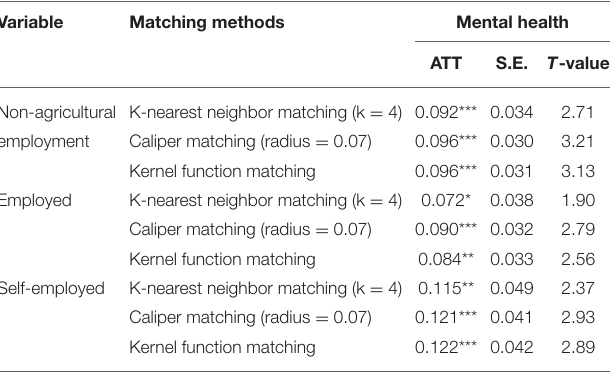
TABLE 6 | Robustness test: propensity score matching estimation